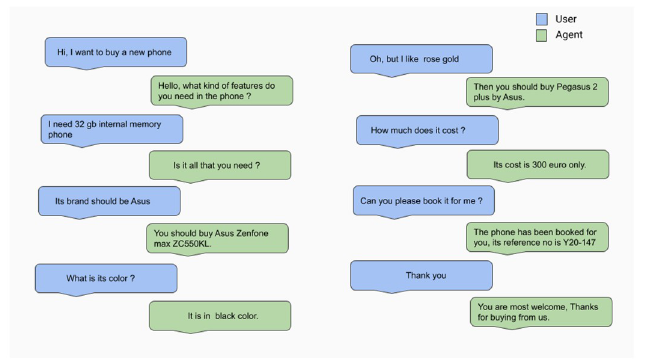
Fig 11. VA performance during